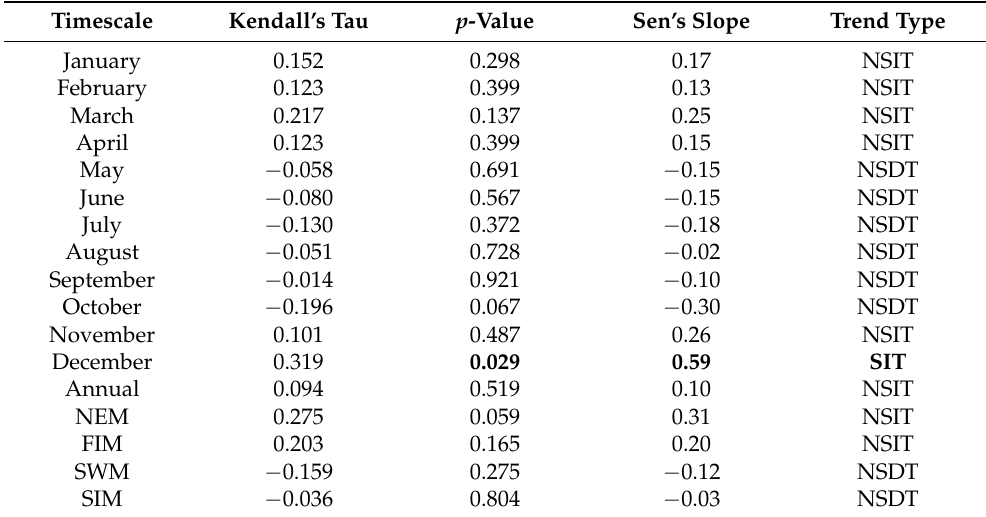
Table 4. Trend analysis results for the streamflow data.